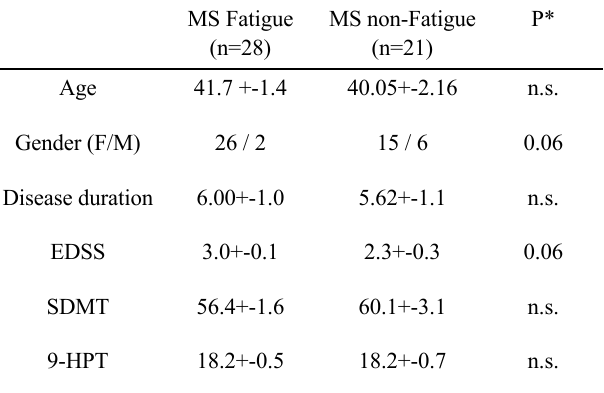
Table 1. Demographic and clinical characteristics of patient